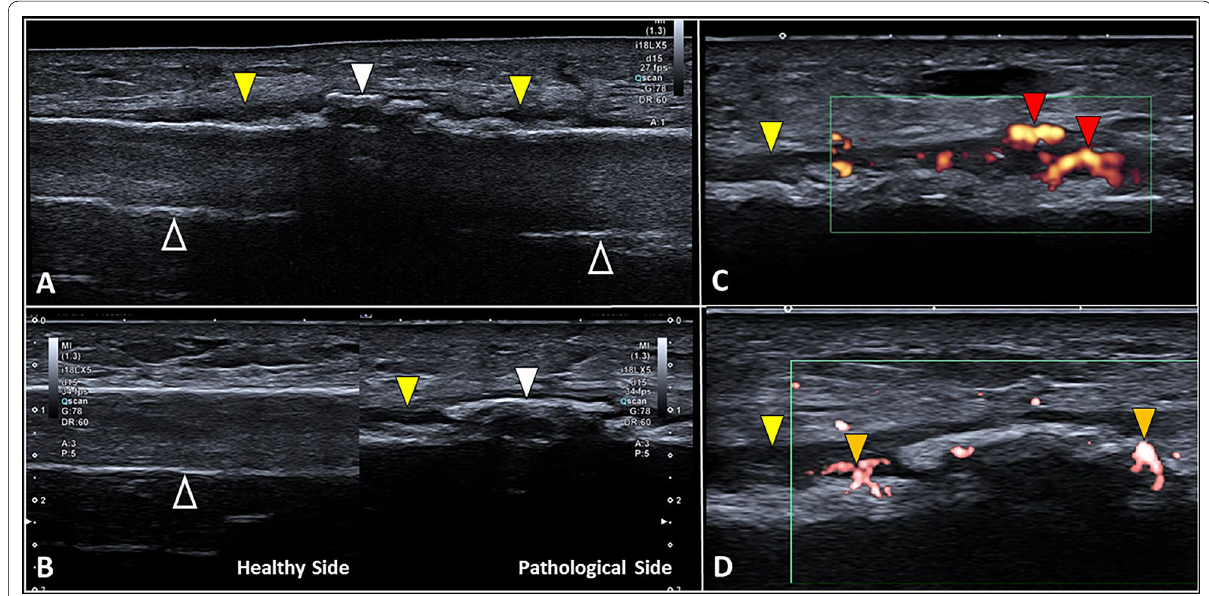
Fig. 5 Stress fractures and healing phases. Focal thickening of the periosteum ( yellow arrowhead ), the disappearance of the reverberation artifact ( void arrowheads ) of the cortical bone, and lamellar calcifications ( white arrowhead ) within the periosteum are the most common sonographic findings in the stress fractures ( A , B ). Using high-sensitive color Doppler to follow up the healing phases of the stress fracture, microvasculature ( red arrowheads ) within the thickened periosteum ( yellow arrowhead ) ( C ) and penetrating vessels ( orange arrowheads ) crossing through the cortical bone ( D ) can be